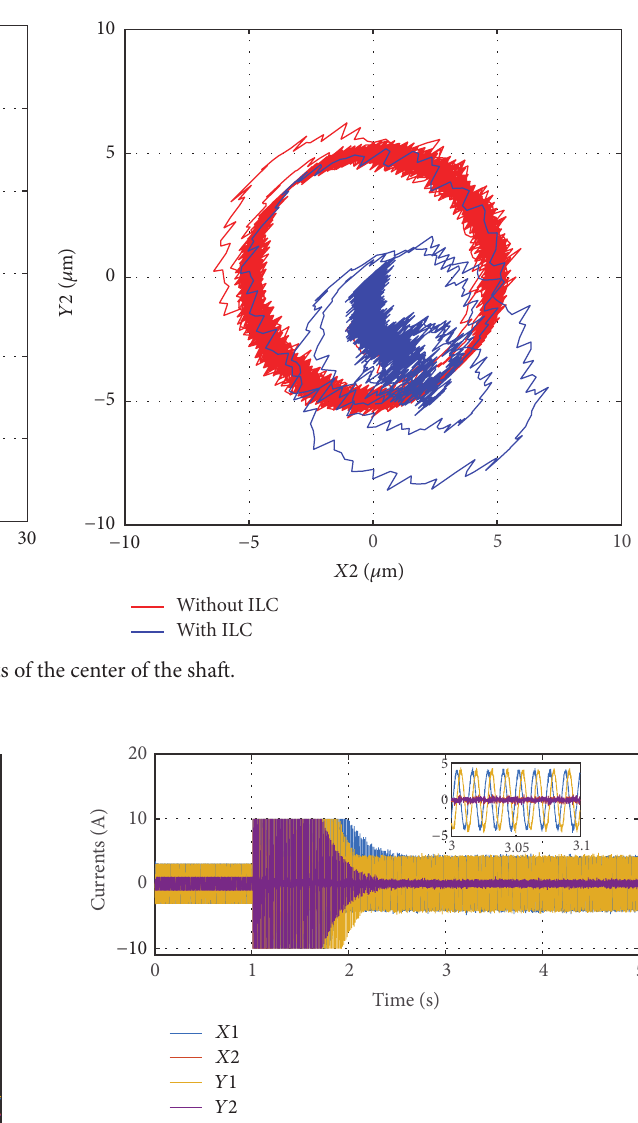
Figure 13: Control currents in radial